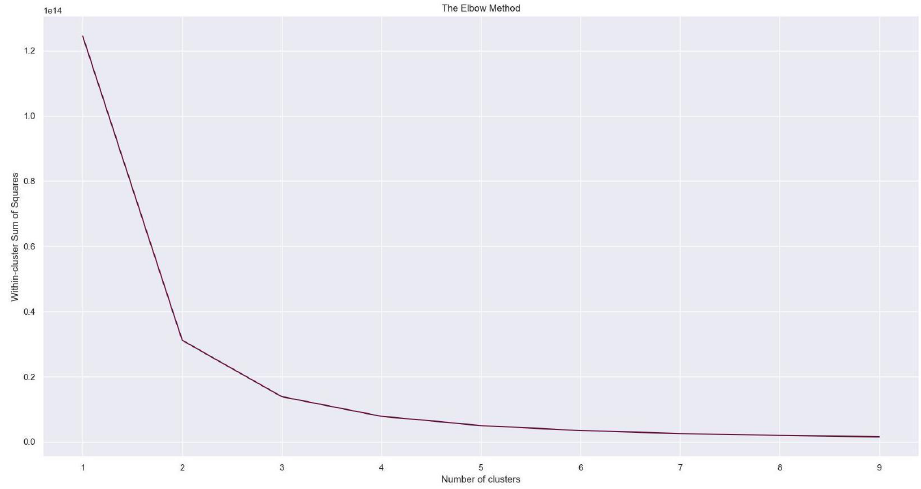
Figure 6. Elbow Method